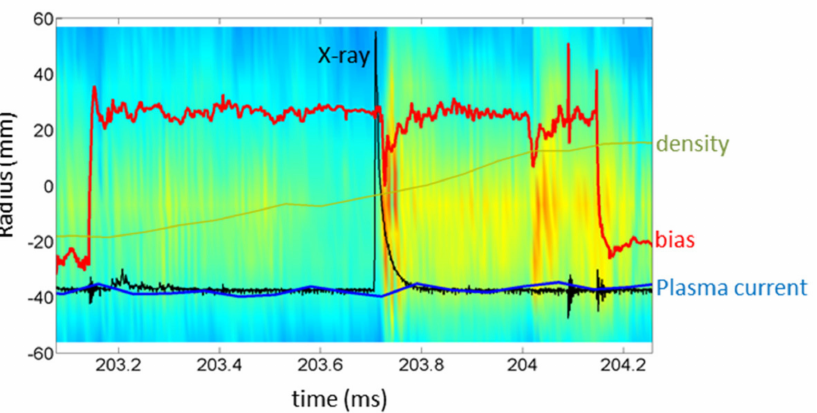
Figure 12. The colored background represents the contour plot of ‘ n sigma ’ evolution (a.u.) covering the plasma radius from about ± 50 mm. Superimposed signals show the plasma current, plasma density and electrode biasing voltage (a.u.). It is clearly seen that, following the X-ray signal, the ‘ n sigma ’ profile increases in the plasma core